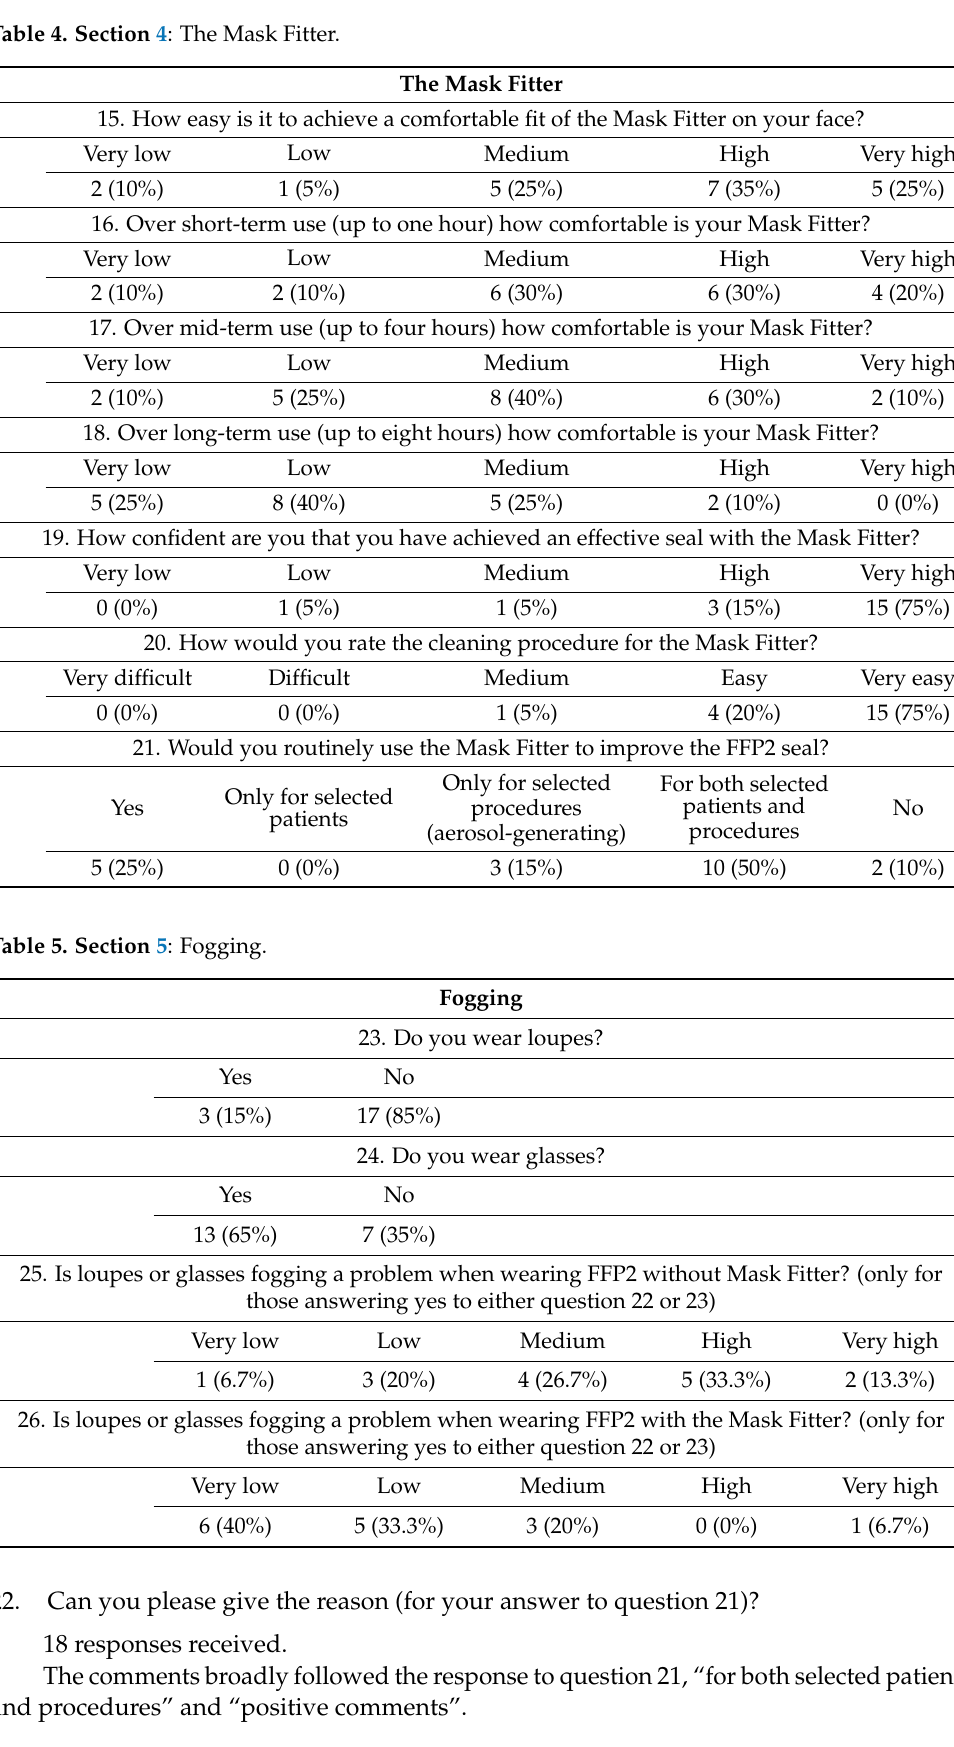
Table 4. Section 4 : The Mask Fitter.